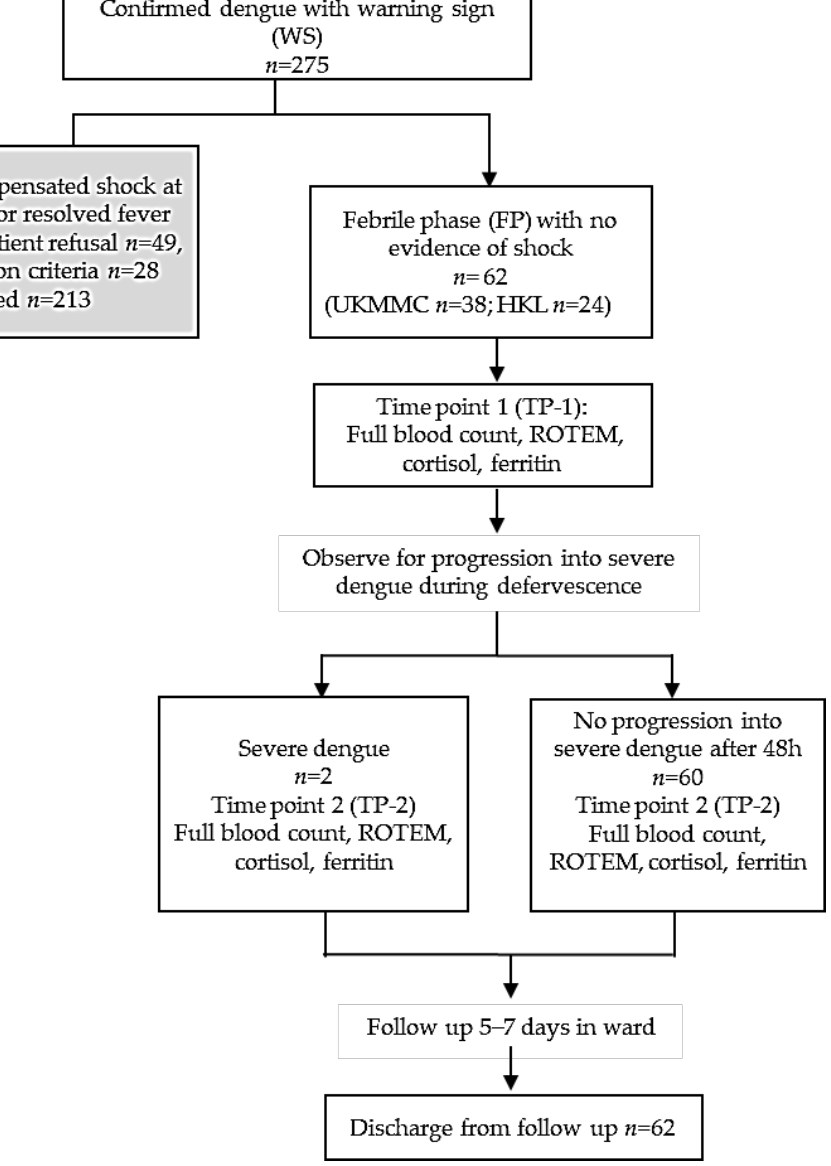
Figure 1. Study protocol and flow chart.